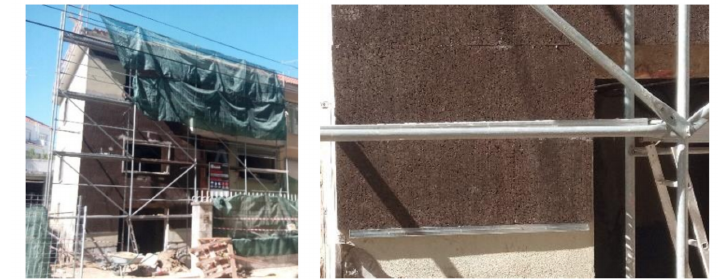
Figure 4. ETICS with ICB (insulation cork board) application (case D).